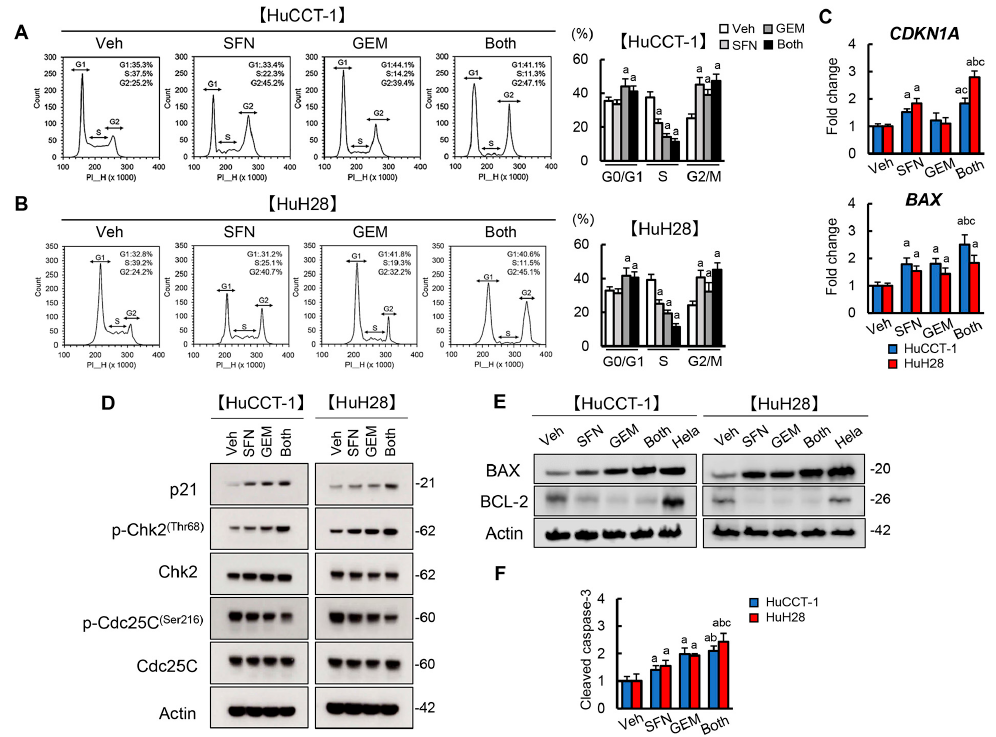
Figure 3. Cell cycle and apoptosis by treatment with SFN and GEM in iCCA cells. ( A , B ) Repre- sentative images of flow cytometric analysis for cell cycle distribution and percentages of cells at different cell cycle phases (G0/G1, S and G2/M) in HuCCT–1 ( A ) and HuH28 ( B ) cells treated with SFN and/or GEM. After the incubation with both agents for 12 h, cells were stained with propid- ium iodide (PI) and subjected to flow cytometry. ( C ) Relative mRNA levels of CDKN1A and BAX in HuCCT–1 and HuH28 cells. ( D , E ) Western blots for the markers related to G2/M arrest, p21,